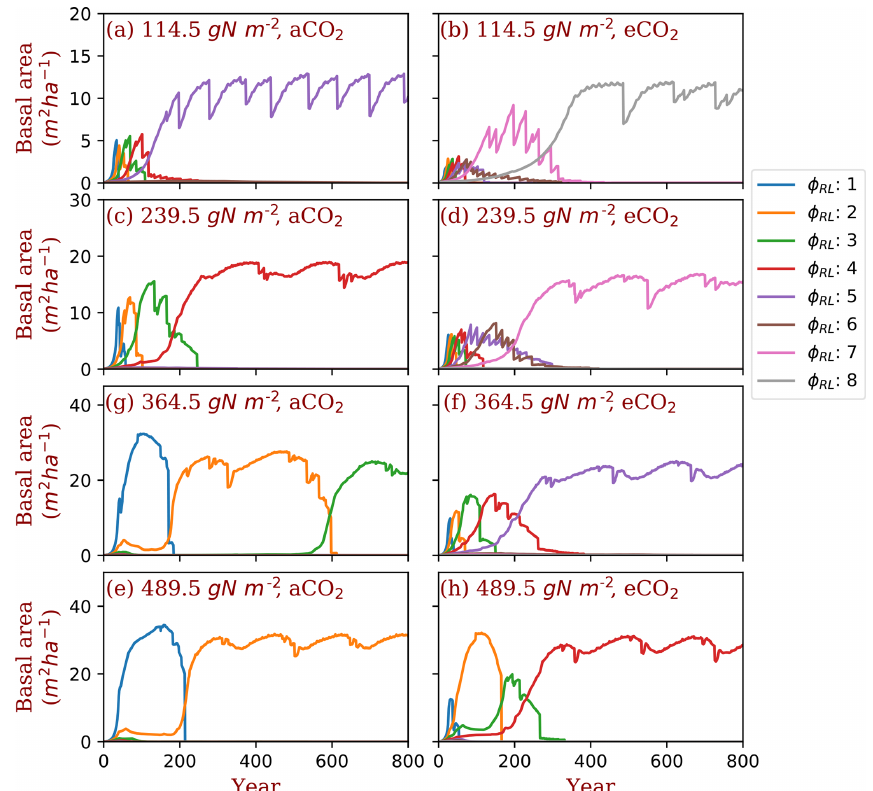
Figure 4. Successional patterns of polyculture run I at ambient and elevated [CO 2 ] concentrations. ϕ RL is the fixed ratio of fine root area to leaf area of a particular